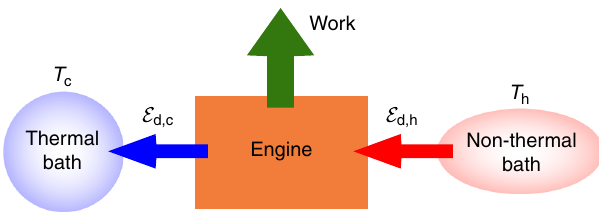
Fig. 4 Engine fuelled by a non-thermal bath. Schematics of an engine fuelled by a hot non-thermal (e.g., squeezed thermal) bath that provides the input energy E d ; h . The engine operates in an arbitrary cycle wherein work is extracted by a piston and an amount of energy E d ; c is dumped into the cold